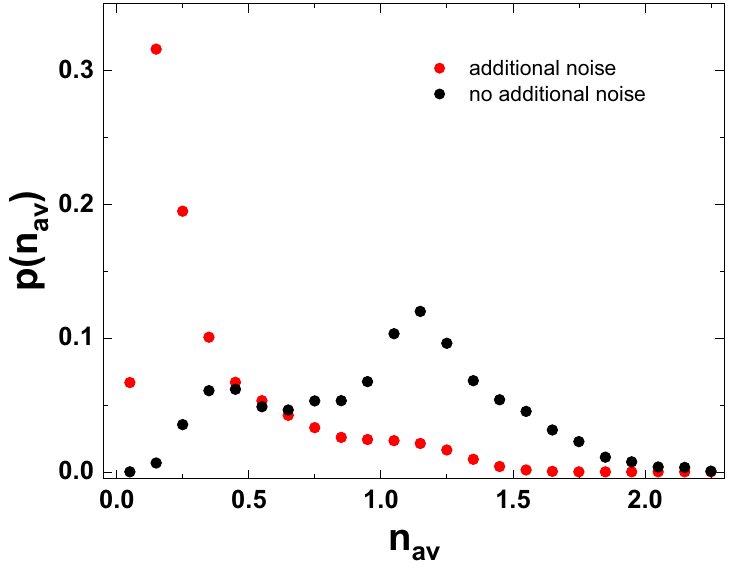
Figure 5. Probability distribution of the mean photon numbers emitted from a polariton condensate ground state during the duration of a local oscillator pulse at an averaging frequency of 75 kHz. Black and red dots denote the distributions in the absence and presence of deliberately added mechanical noise,